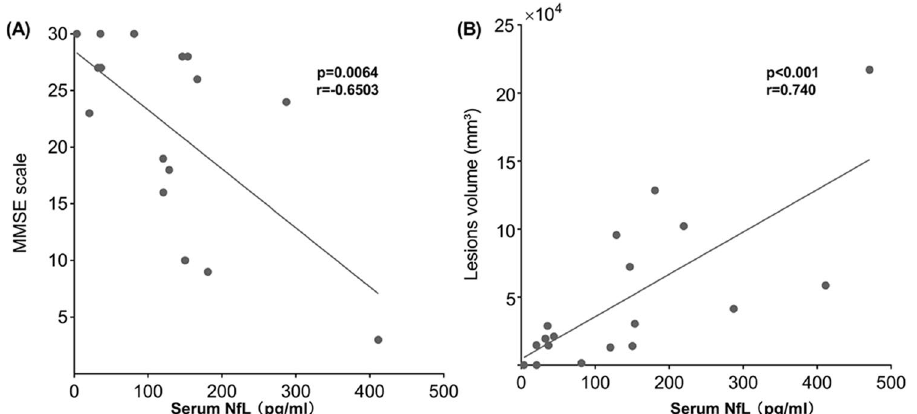
Figure 2. Correlations of serum NfL level with MMSE and stroke-like lesion volume. ( A ) The association of between MMSE scale and serum NfL level; ( B ) the relation between serum NfL level and stroke-like lesion volume. MMSE Mini-Mental State Examination, NfL neurofilament light, lesion volumes stroke-like lesion